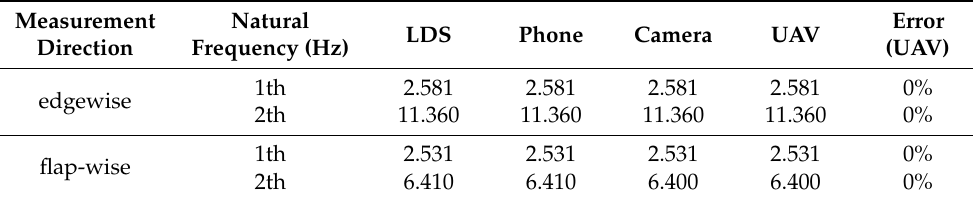
Table 2. Identification results of edgewise and flap-wise natural frequencies of wind turbine blades.